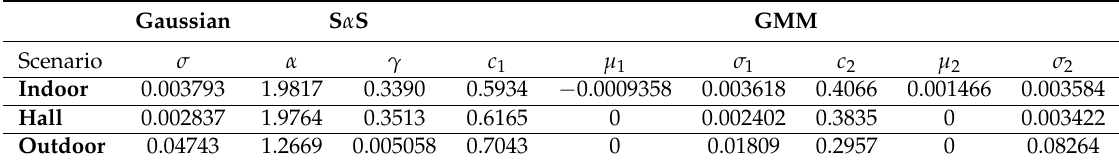
Table 1. Parameters estimated for Gaussian, Gaussian mixture model, and α -stable